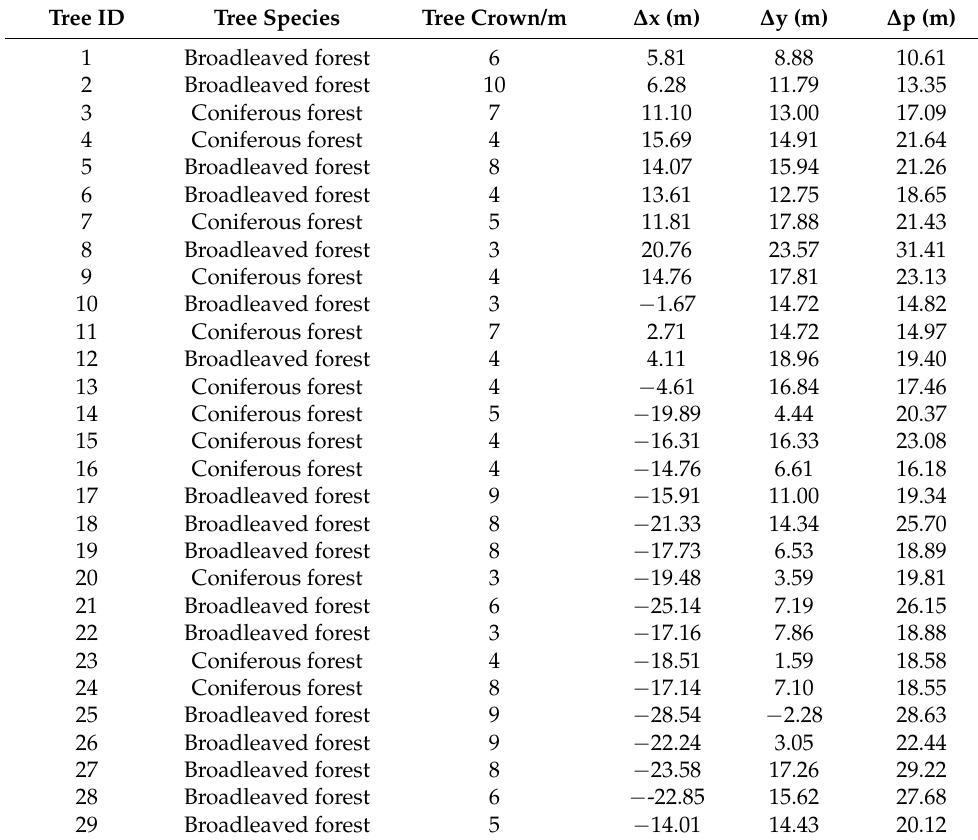
Table 4. Galaxy 6 RTK GNSS single-point positioning precision solution positioning error.